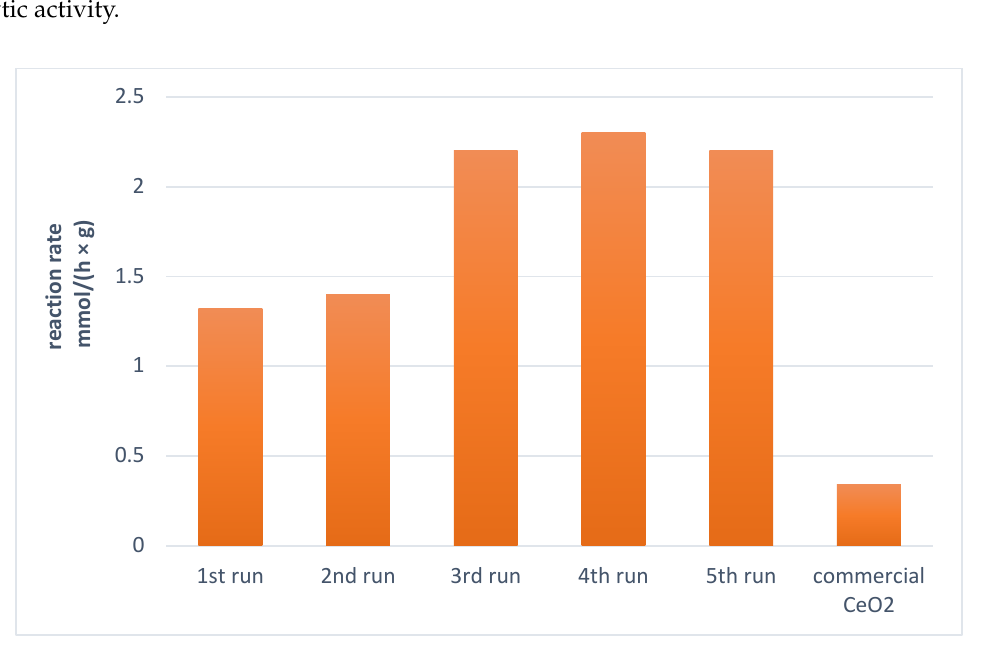
Figure 13. Recyclability of Fe 3 O 4 / 1.5CeO 2 in the imine formation reaction, under the reaction conditions reported in Scheme 1. The last histogram is referred to commercial nanoceria calcined at 400 ◦ C for 3 h under